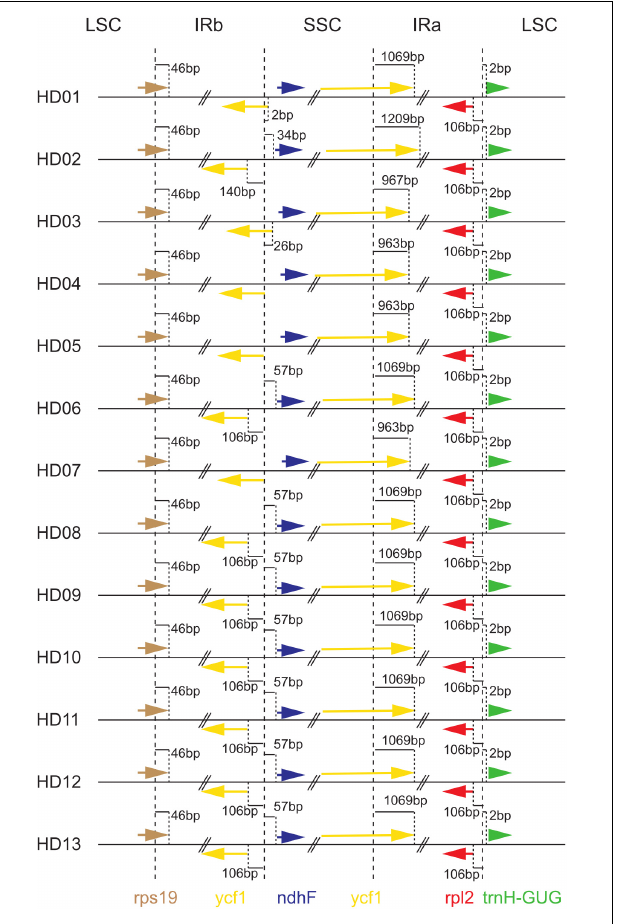
FIGURE 2 | Comparison of the border positions of large single-copy (LSC), inverted repeat (IR) and small single-copy (SSC) among the thirteen chloroplast genome